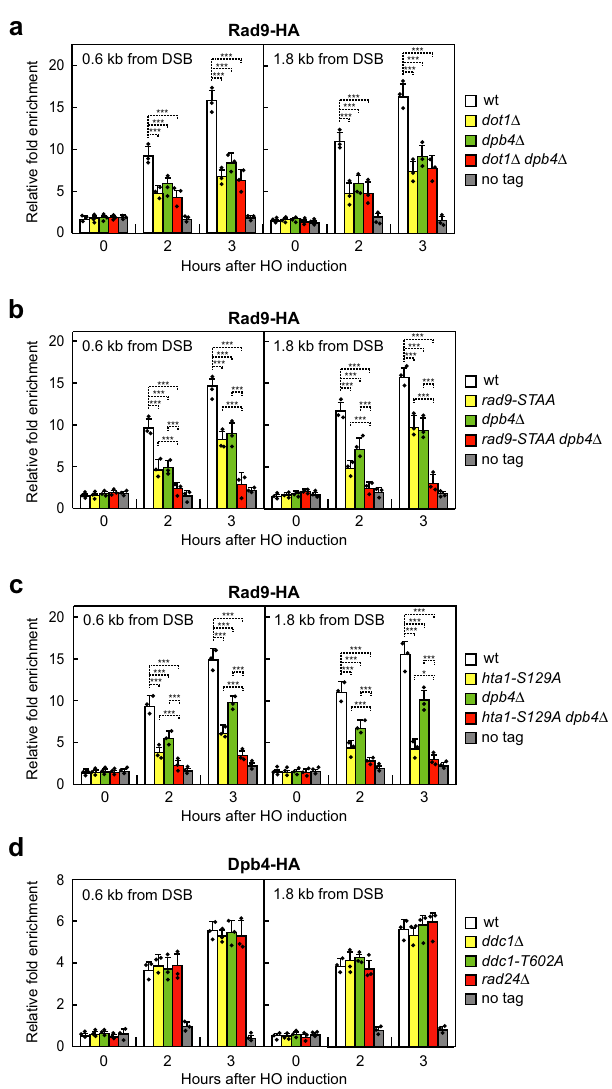
Fig. 5 Dpb4 promotes Rad9 association at DSBs independently of γ H2A and Dpb11 – Rad9 interaction and by acting in the same pathway of Dot1. a – d Exponentially growing YEPR cell cultures of JKM139 derivative strains were transferred to YEPRG to induce HO expression. Relative fold enrichment of Rad9-HA ( a – c ) and Dpb4-HA ( d ) at the HO-induced DSB at the MAT locus was evaluated after ChIP with anti-HA antibody and qPCR. Strains carrying the hta1-S129A allele also contain the deletion of the HTA2 gene. The mean values of three independent experiments are represented with error bars denoting s.d. *** p < 0.005; * p < 0.05 (un p aired two-tailed Student ’ s t